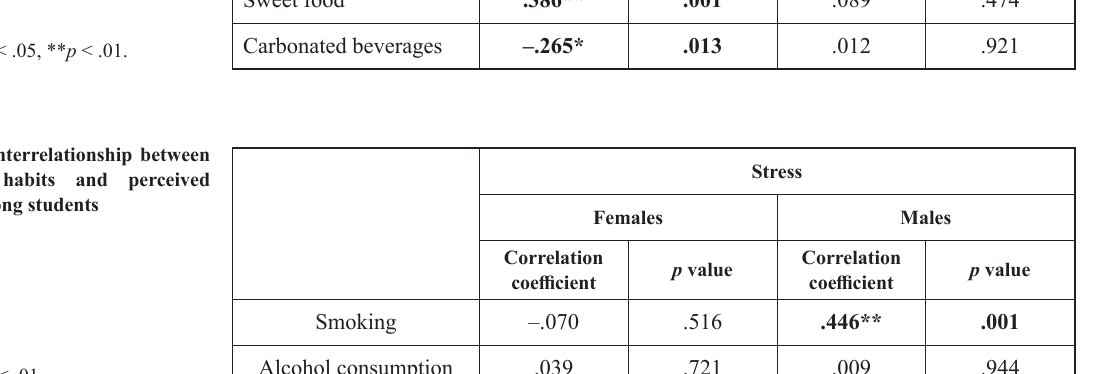
Notes . * p < .05, ** p < .01.